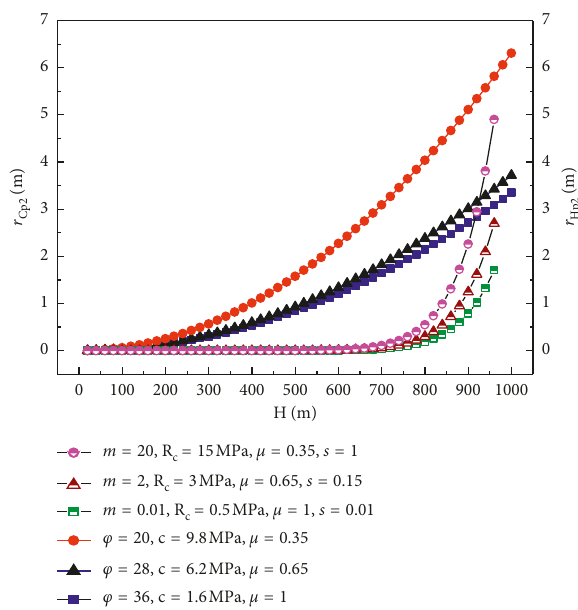
Figure 7: The influence curve of damaged width of rib pillar by burial